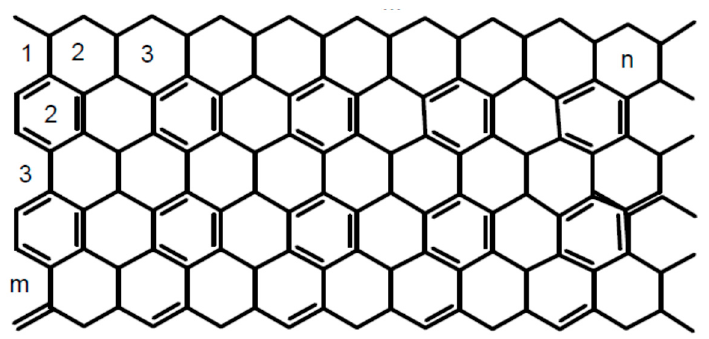
Figure 2. The 2-D graph of zig-zag nanotube T Z [5,10].